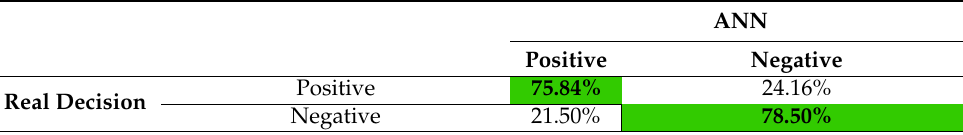
Table 3. Confusion matrix for artificial neural